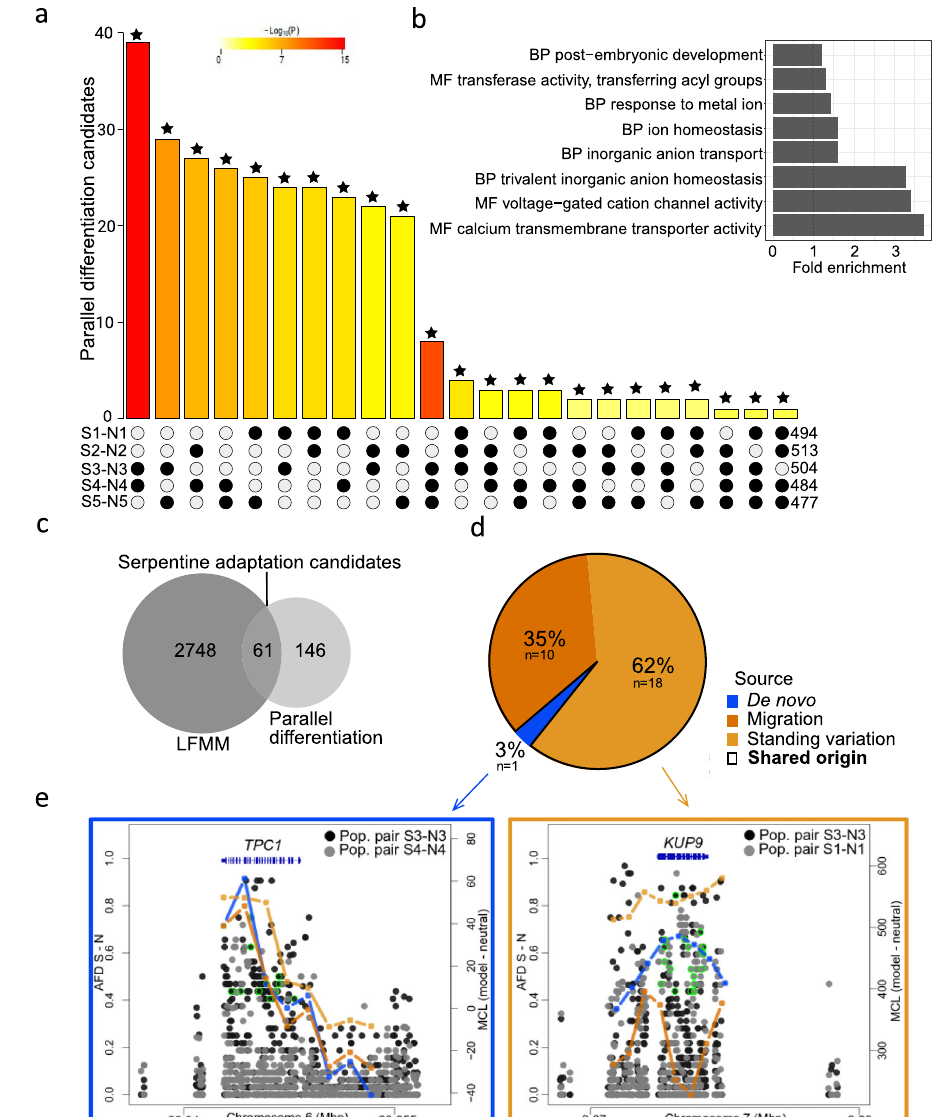
Fig. 2 Parallel serpentine adaptation candidates and the sources of parallel variants in A. arenosa . a Intersection of candidates from each population pair (S1 – N1 to S5 – N5) demonstrating more genes repeatedly found as candidates across two, three, and four population pairs than expected by chance alone (all intersections were signi fi cant at p < 0.01 (highlighted by asterisks), one-sided Fisher ’ s exact test); note: the colour intensity of the bars represents the p value signi fi cance of the intersections. b Gene ontology (GO) enrichment of the candidates (across all population pairs); GO categories: biological process (BP) and molecular function (MF); for complete list of GO terms, see Supplementary Data 4. c Overlap between parallel differentiation candidates and latent factor mixed model (LFMM) candidates resulting in 61 serpentine adaptation candidate genes. d Proportions of serpentine adaptation candidates originating from de novo mutations or being of shared origin out of the total of 29 cases of non-neutral parallelism as inferred by the Distinguishing among Modes of Convergence approach (DMC; see text for details). e Two examples of parallel candidate loci, illustrating nucleotide divergence and maximum composite log-likelihood (MCL) estimation of the source of the selected alleles in these particular loci inferred in DMC. Allele frequency difference (AFD) for locus with independent de novo mutations (left) and with parallel recruitment of shared ancestral standing variation (right). Left y -axis: AFD between S and N populations. Dots: AFD values of individual SNPs; bright green circles: non-synonymous SNPs with AFD ≥ 0.4; lines (right y -axis): MCL difference between neutral versus parallel selection scenario following colour scheme in d ; gene models are in